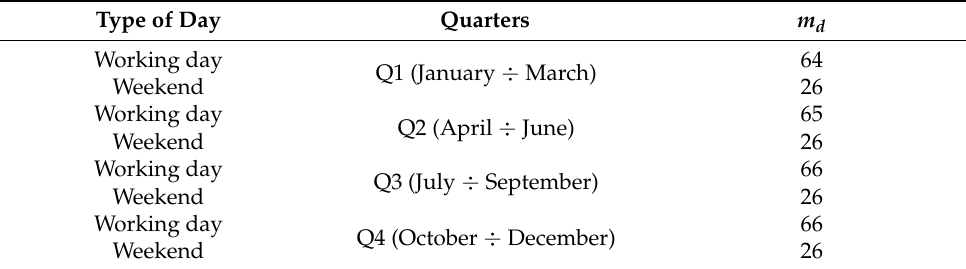
Table 2. Representative days adopted in the case study.